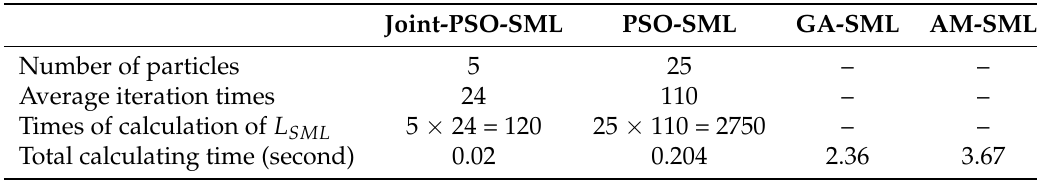
Table 6. Comparison of computational complexity of Joint-PSO, PSO, GA and AM for SML. Scenario: p = 8, q = 2, r = 1 ( coherent ) , N = 100, SNR = 0 dB, The ture DOA: 30 ◦ and − 10 ◦ , 30 independent trials, RMSE =